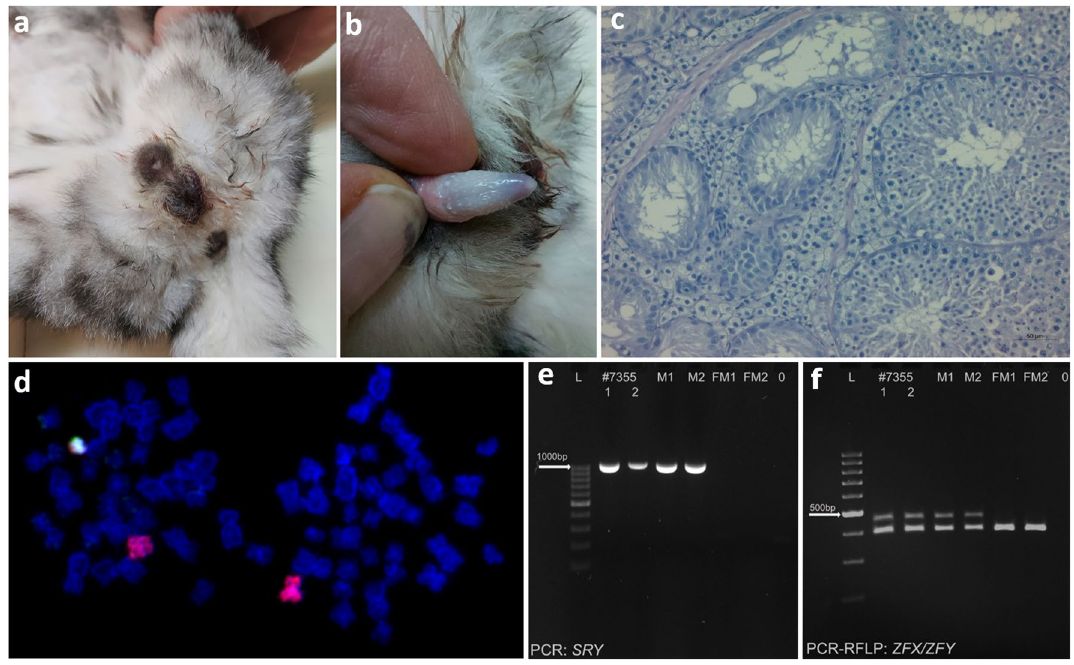
Figure 2. Characteristics of DSD case #7355: ( a, b ) normal male external genitalia; ( c ) histology of gonads: testes with degenerated spermatogenesis and rare sperms; ( d ) FISH with X (red) and Y (green) chromosome painting probes showing two cell lines: normal (38,XY) and monosomic (37,X); detection of Y-linked genes in blood leukocytes: ( e ) SRY : 1022 bp band detected by PCR, and ( f ) ZFY : 448 bp band (391 bp band represents the X-linked ZFX gene) detected by PCR–RFLP, L: 100 – 1000 bp ladder, lanes 1, 2: case #7355 (duplicated), M1, M2: control males; FM1, FM2: control females; 0: negative